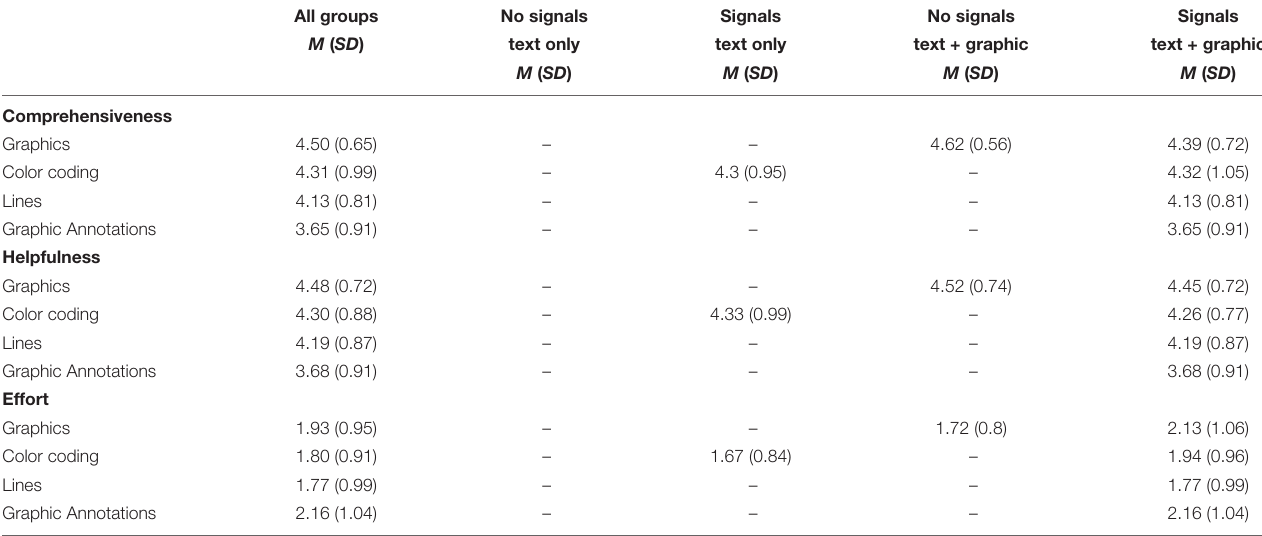
TABLE 4 | Means and standard deviations of the subjective rating on a five-point Likert scale. All groups No signals Signals No signals